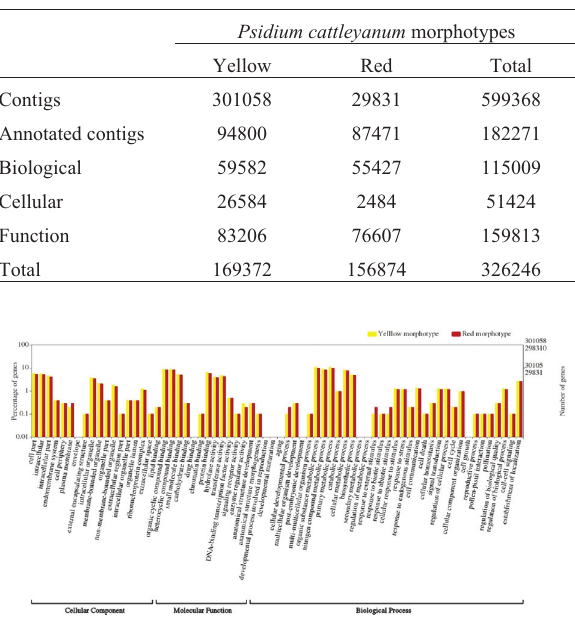
Figure 3 - Functional annotation and comparison of the GO terms among the leaf and unripe and ripe transcriptome sequences in the yellow and red morphotypes of P. cattleyanum .